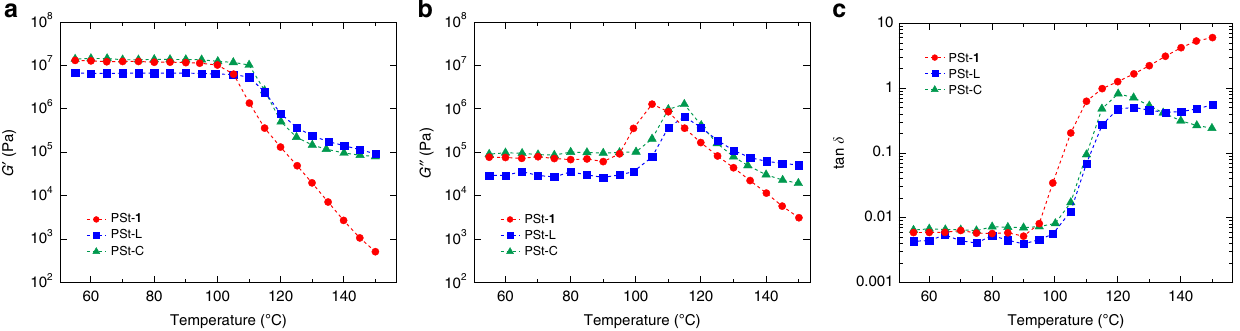
Fig. 5 DMA data for PSt-1, PSt-L, and PSt-C. Temperature sweeps of: a storage modulus ( G ′ ), b loss modulus ( G ″ ), and c loss factor (tan δ = G ″ / G ′ ) for PSt- 1 (red), PSt-L (blue), and PSt-C (green) at a frequency ω of 1 s − 1